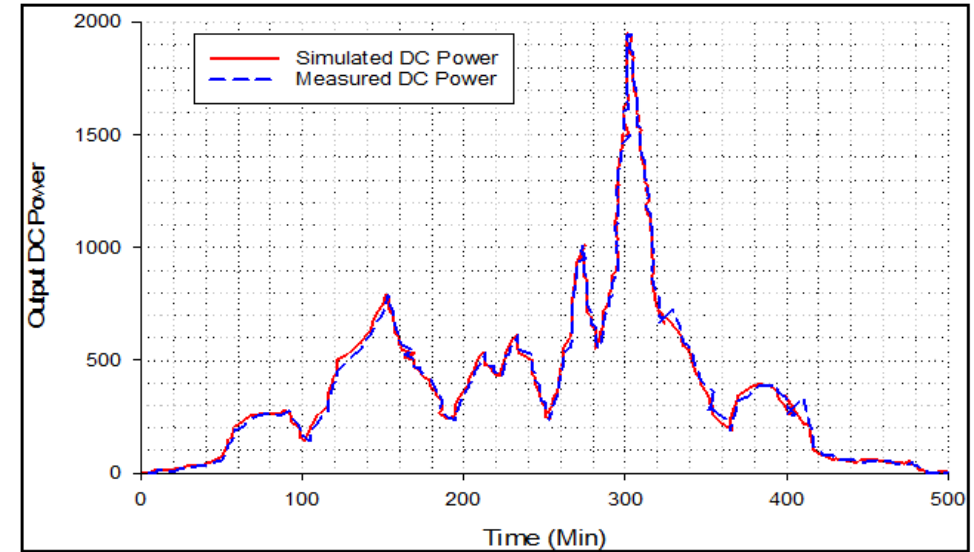
Figure 6. DC simulated power versus measured power (normal operation).